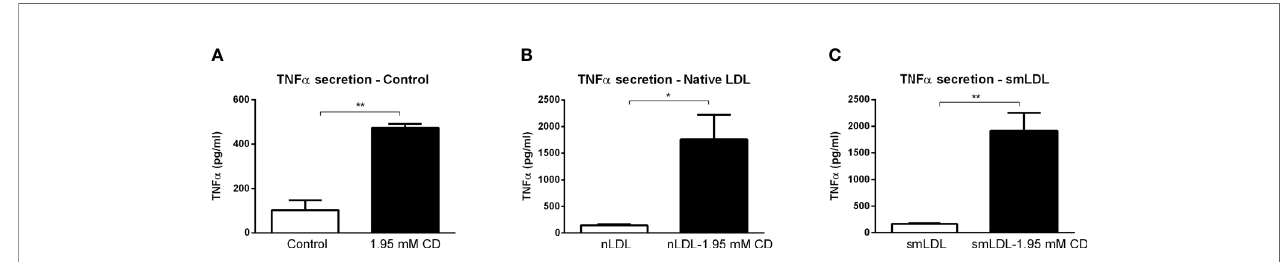
FIGURE 6 | THP1 cell line-related parameters of in fl ammation after prolonged exposure to 2-hydroxypropyl- b -cyclodextrin. (A – C) TNF a protein levels of control, nLDL or smLDL (24hr)-exposed THP1 cells treated with or without 2-hydroxypropyl- b -cyclodextrin (1.95 mM; 4hr). *, ** indicates p < 0.05 and 0.01 by means unpaired t-test. Data represent n = 3 for each